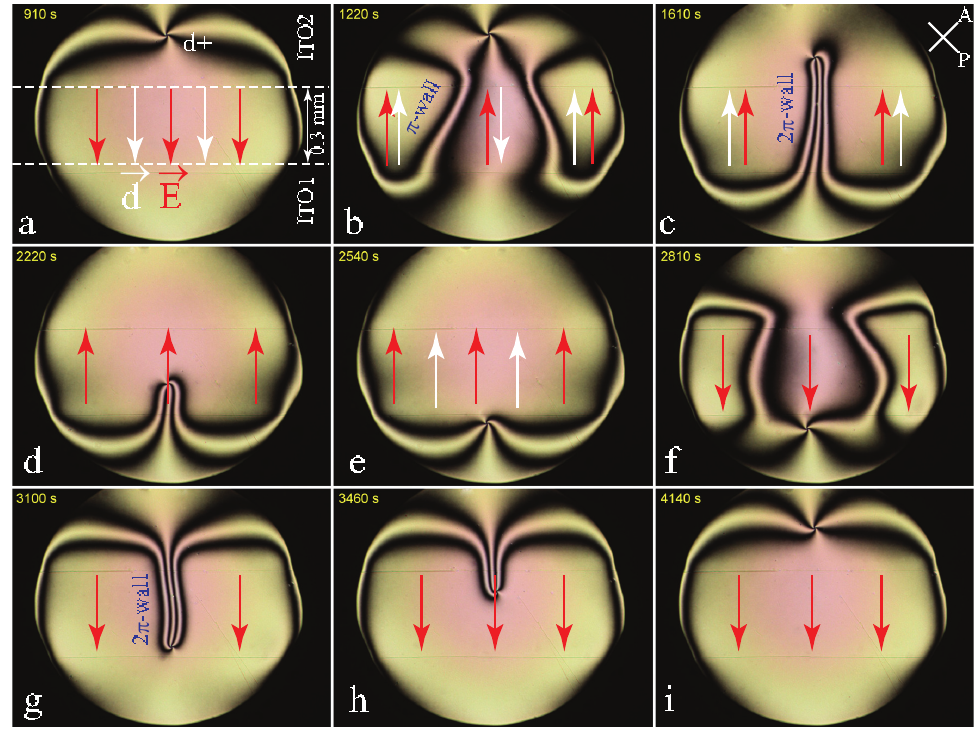
Figure 9. The evidence for the polarisation of the dowser texture in 5CB: formation of a 2 π -wall upon application of the electric field to the sample containing one dowson d+.